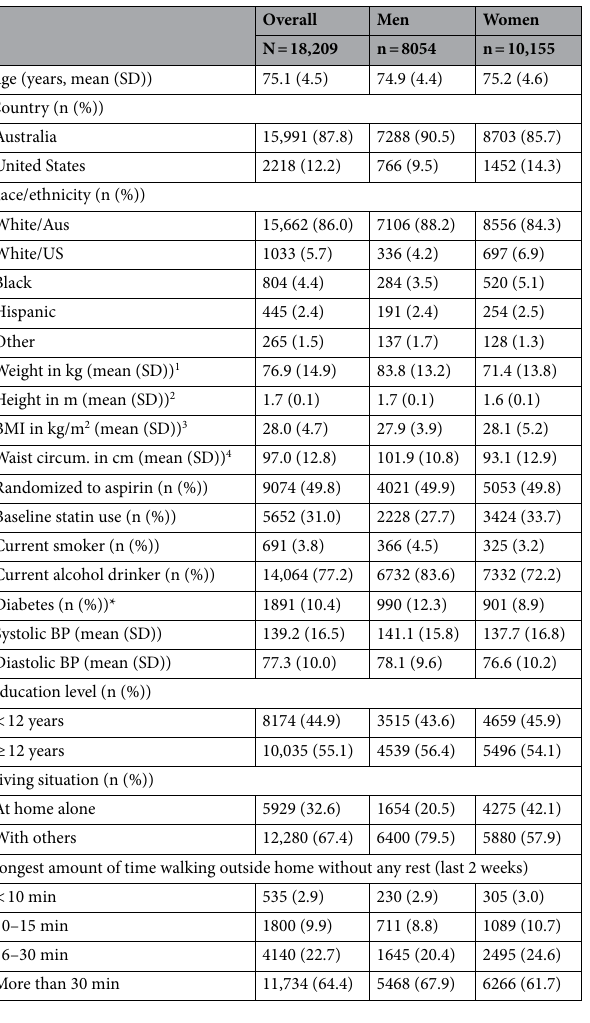
Table 1. Baseline characteristics of the ASPREE participants included in the current analyses. Number of participants missing baseline measurement for the following variables: 1 n = 35, 2 n = 28, 3 n = 60, 4 n = 172. SD, standard deviation; BMI, body mass index; BP, blood pressure. *Diabetes defined as a self-report, fasting glucose ≥ 126 mg/dL, or receiving pharmacologic treatment for diabetes (regardless of fasting glucose level).